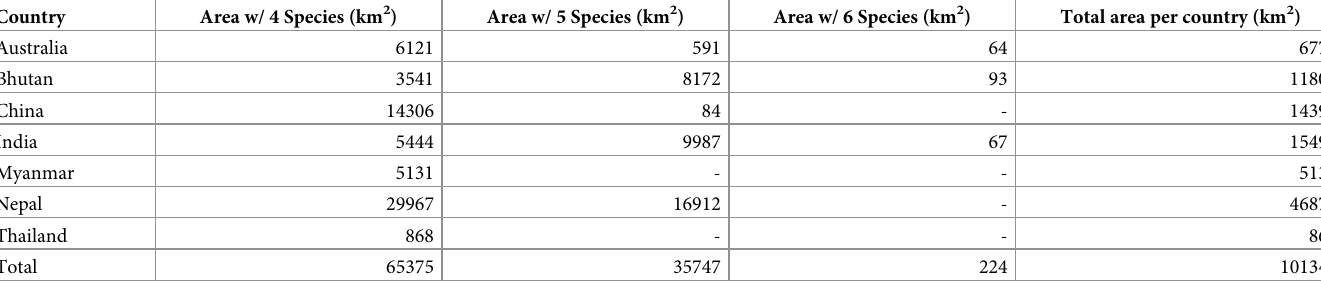
Table 2. The area within each country with 4 or more species that have overlapping ranges and habitat restoration potential. Country